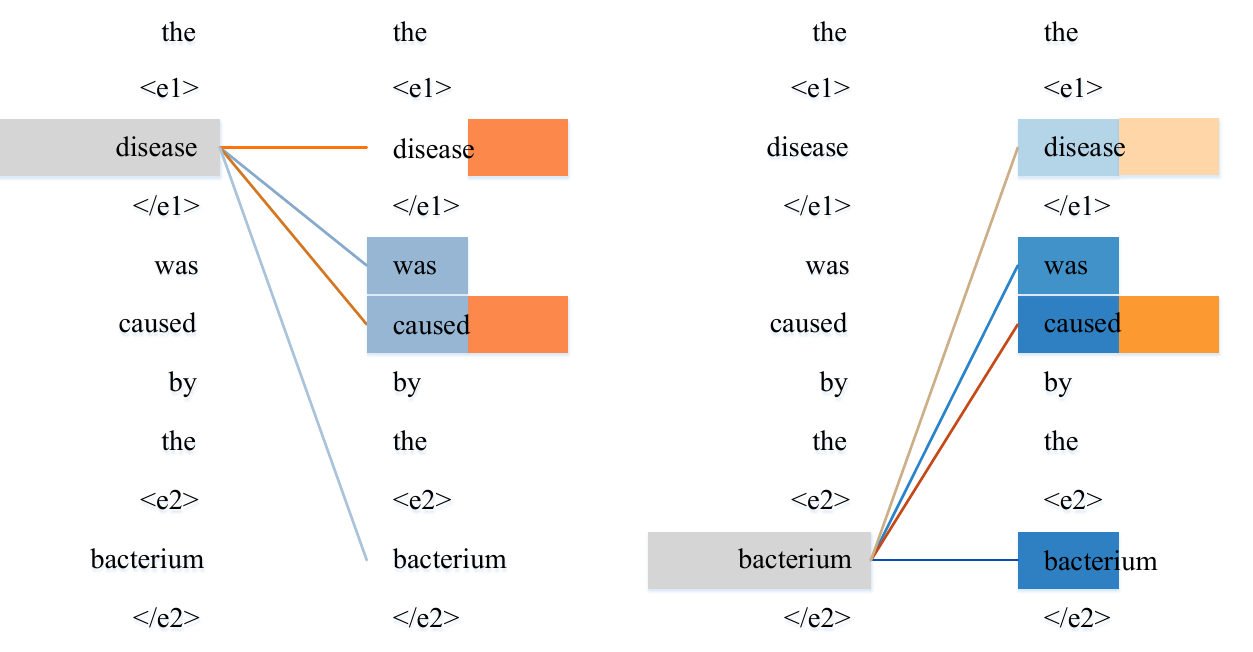
Figure 6. Visualization of self-attention.